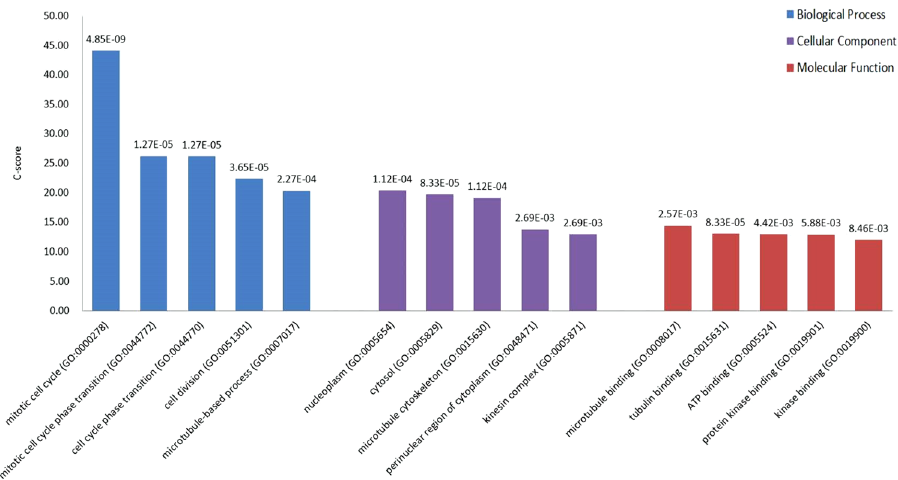
Figure 8. Top 5 enriched GO terms for genes in the integrated diagnostic